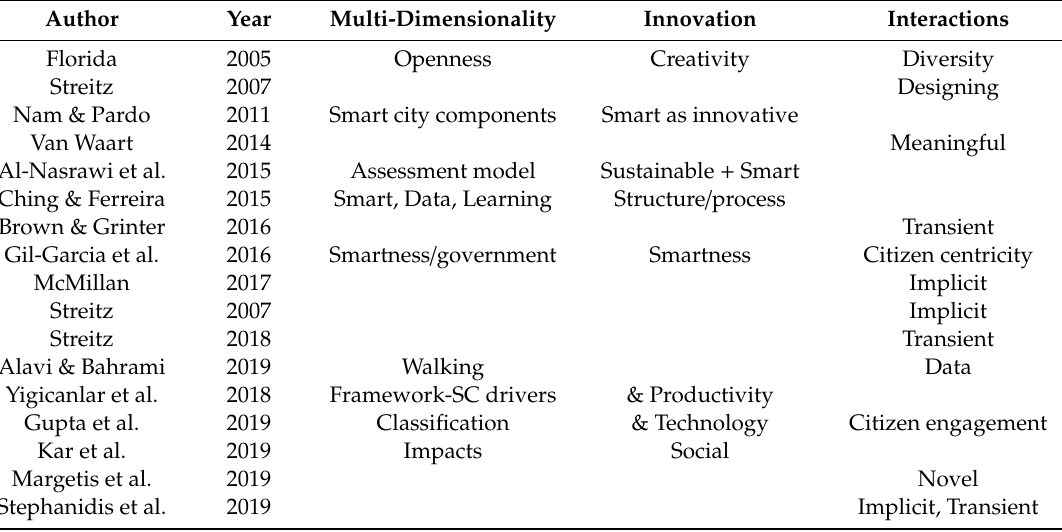
Table 2. Smart city multi-dimensionalities and innovation and interactions by year,